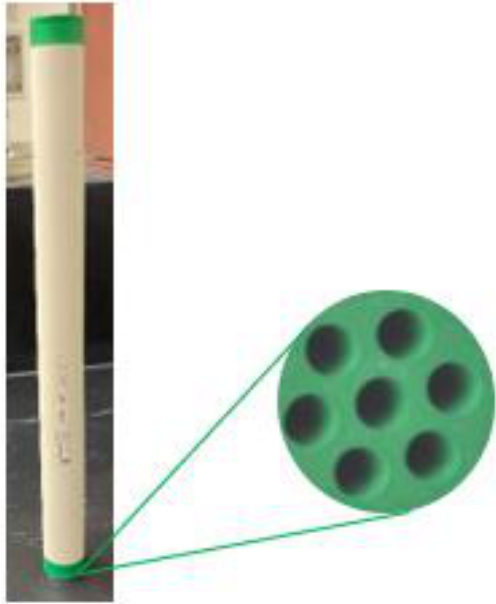
Figure 3. Ceramic membrane representation and its cross-sectional area.